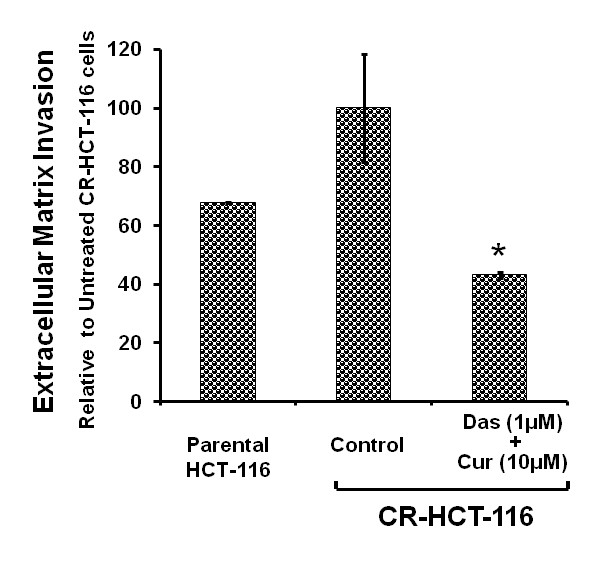
Effects of dasatinib and curcumin on extra cellular invasion by CR HCT-116 colon cancer cells. CR HCT-116 cells were allowed to invade in the presence or absence of dasatinib(1 μM), and curcumin (10 μM) for 3 days. The invading cells were stained with crystal violet and solubilized for quantitation. The controls represent the parental cells or CR HCT-116 cells that were incubated with FOLFOX (50 μM 5-FU + 1.25 μM oxaliplatin) containing medium only. *P < 0.01, compared with the corresponding control.